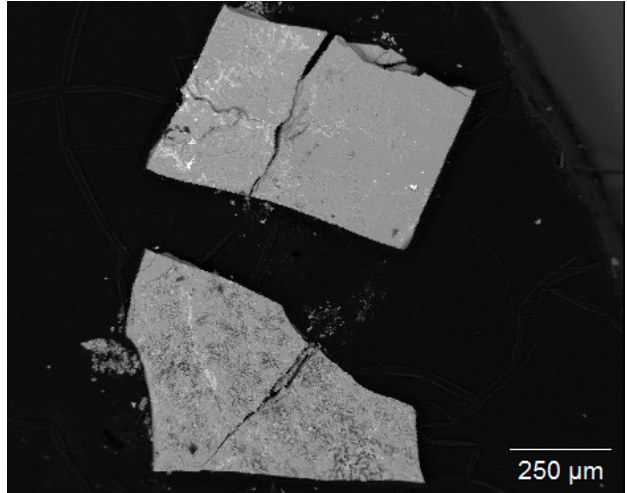
Figure 1. Backscattered electron scanning electron microscope (SEM) picture of two exemplary crystals, which were investigated via wavelength dispersive X-ray spectroscopy (WDX).